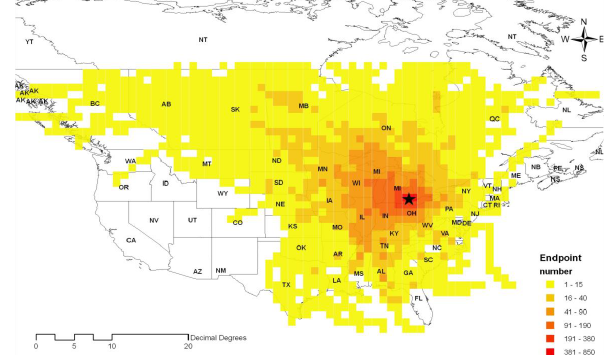
Fig. 3. Map of total number of end points in each grid cell (Star indicates Windsor).